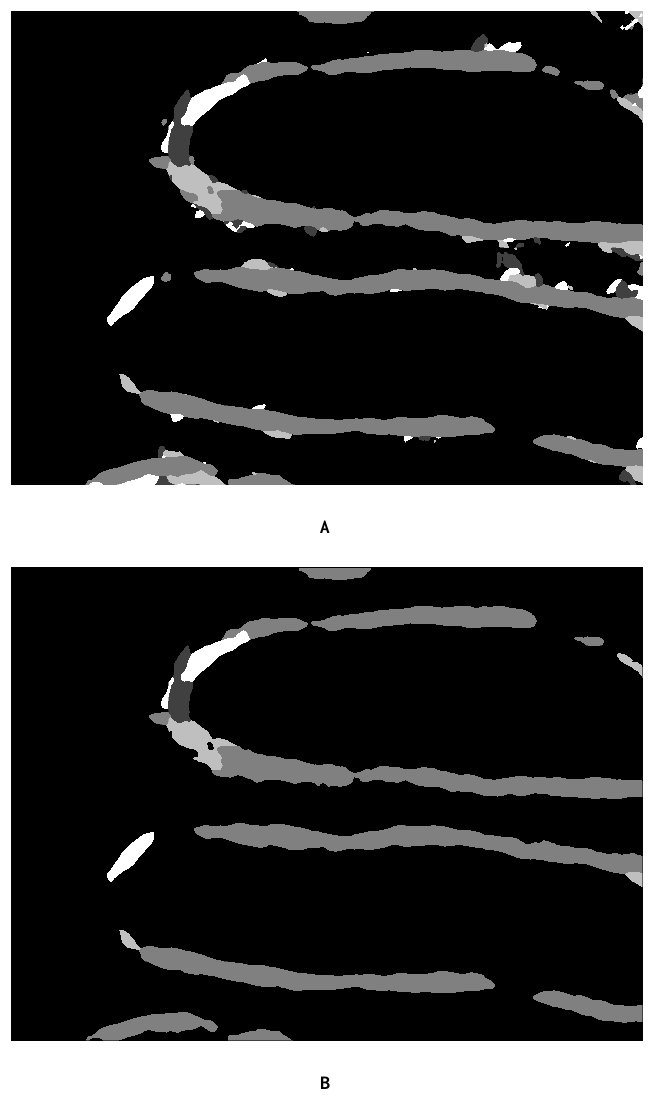
FIGURE 11. Postprocessing. (A) The mapping in which a nonblack level corresponds to the directional window that yields the largest ratio among the four; (B) defects either too small or unfit in shapes removed; (C) possible extension area with directional dilation; (D) expanding area; (E) final